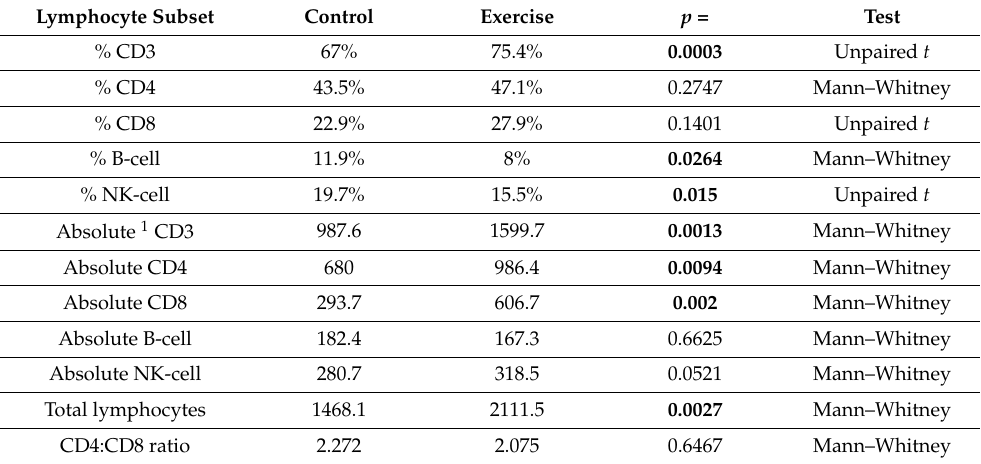
Table 5. Comparison of mean lymphocyte counts between exercise and control groups. Bold highlights significant values ( p < 0.05).